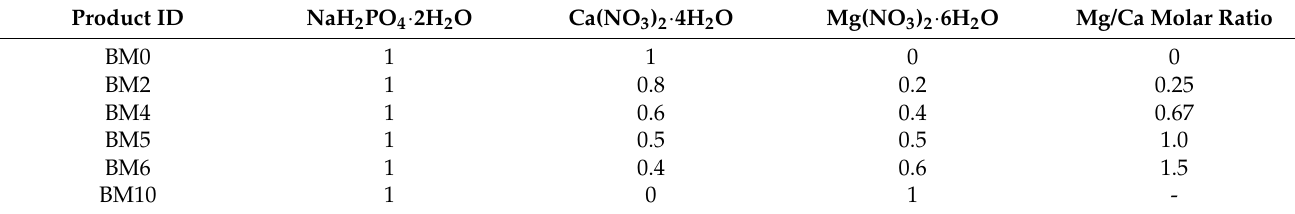
Table 1. Molar proportions of NaH 2 PO 4 · 2H 2 O, Ca(NO 3 ) 2 · 4H 2 O and Mg(NO 3 ) 2 · 6H 2 O as well as Mg/Ca molar ratios used for the synthesis of Ca 1 − x Mg x · HPO 4 · nH 2 O compounds. Product